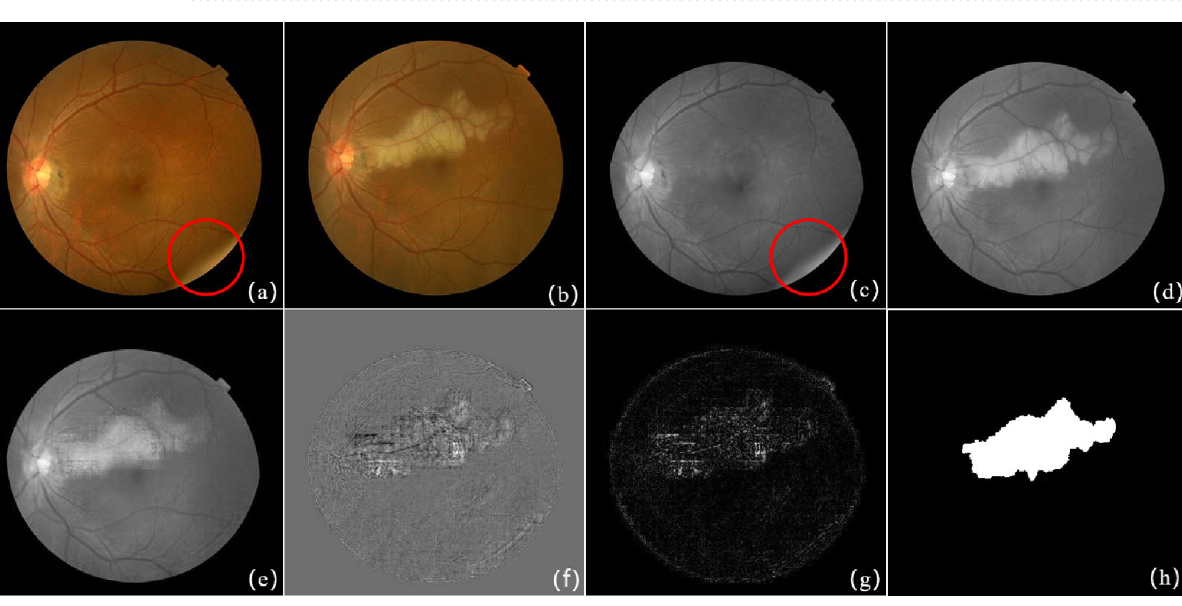
Figure 6. The result of image pair with large lesions. ( a ) Reference image; ( b ) current image; ( c ) grayscale image of ( a ); ( d ) grayscale image of ( b ); ( e ) the reconstructed background of ( d ) based on the proposed method; ( f ) the difference image of ( d ) and ( e ); ( g ) the absolute difference image of ( d ) and ( e ); ( h ) the